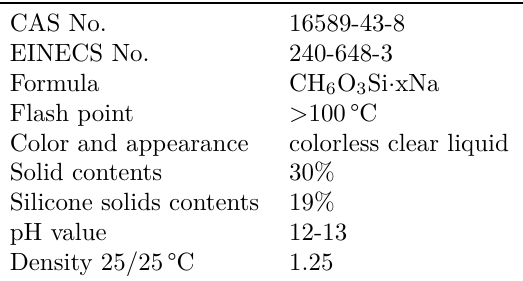
Table 3. Typical properties of Sodium Methyl Sili-